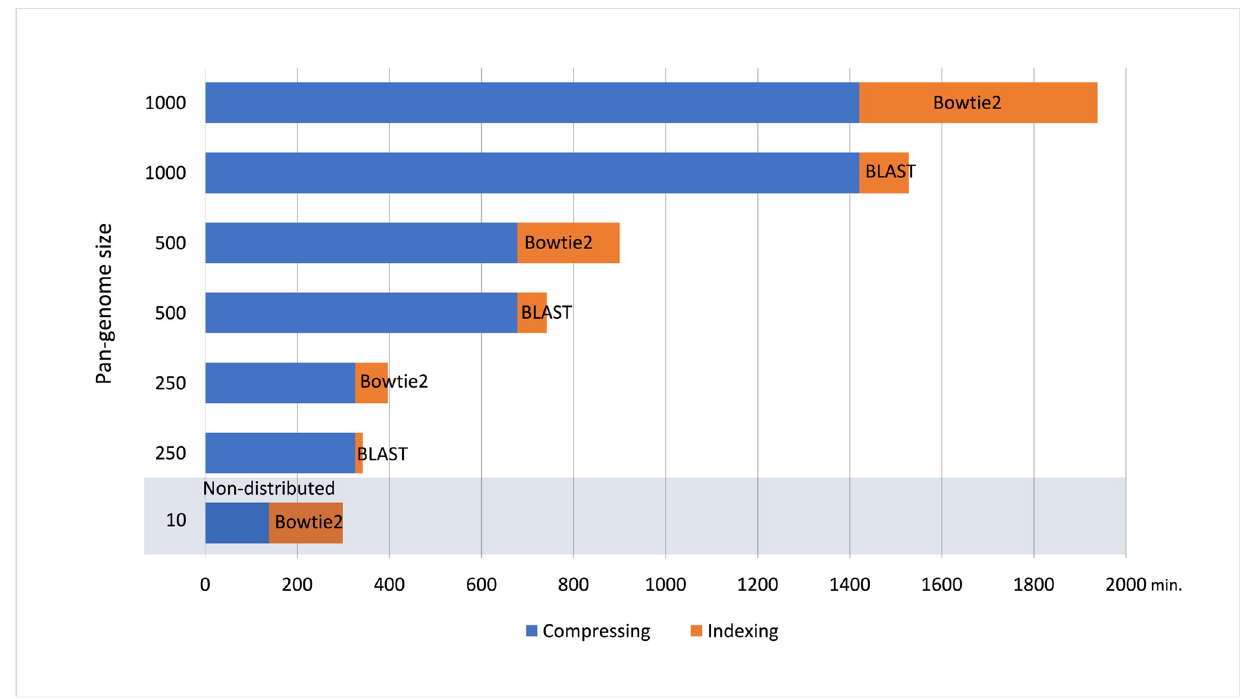
Fig 5. Summary of compressing and indexing complete human pan-genomes with distributed and non-distributed methods. https://doi.org/10.1371/journal.pone.0255260.g005 BLAST with compression ratios of 76:1 and 532:1 respectively. To note, the distributed kernel sequence construction time observed was 62 minutes for n = 500 and 104 minutes for n = 1000 with both tools, and the rest of the indexing time was spent in the index construction with the used tool. The Bowtie2 input kernel sequence size was 2.8 GB for n = 250, 6.8 GB for n = 500 and 16 GB for n = 1000. The BWA was not able to index the same data sets. The CHIC indexer has been run with the maximum query length parameter of 102 base pairs which cov- ers the maximum sequence length of the test datasets used in the alignment experiments. As a reference, we compress and index a human pan-genome (n = 10) with the original CHIC tool (non-distributed in Fig 5). Non-distributed RLZ compression took 138 minutes and Bowtie2